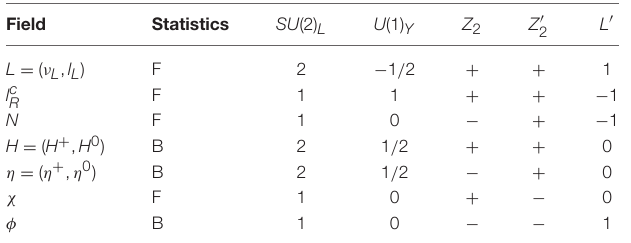
TABLE 2 | The matter content of the model B and the corresponding quantum numbers.